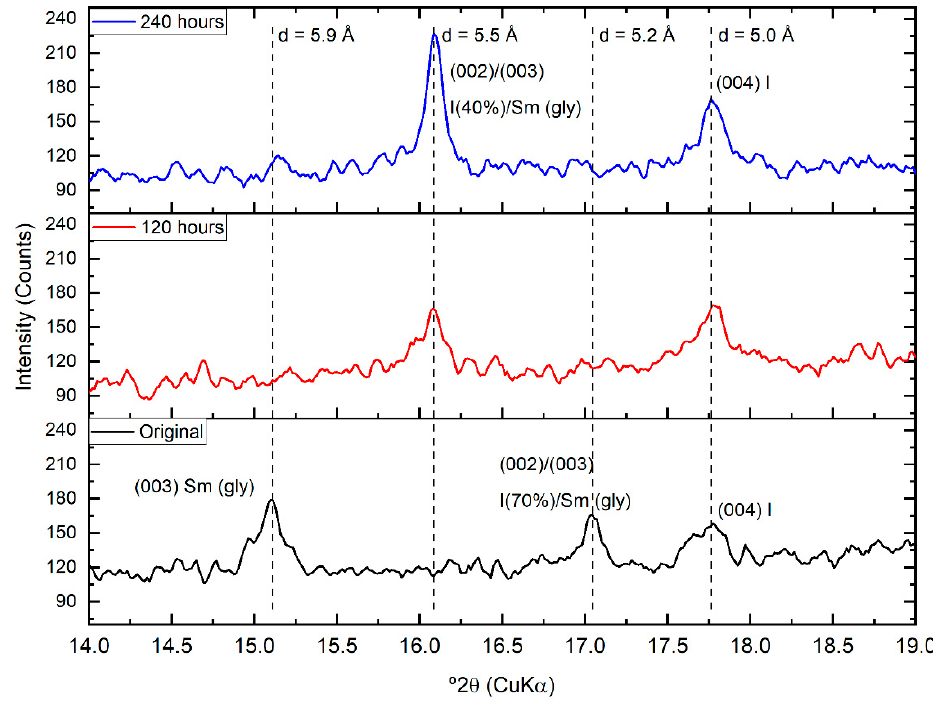
Figure 4. Comparison of XRD patterns (14–19 ◦ 2 θ region) of the original blue marl and the original blue marl oriented and ethylene-glycol original blue marl, after 120 and 240 h of sc-CO 2 interaction.